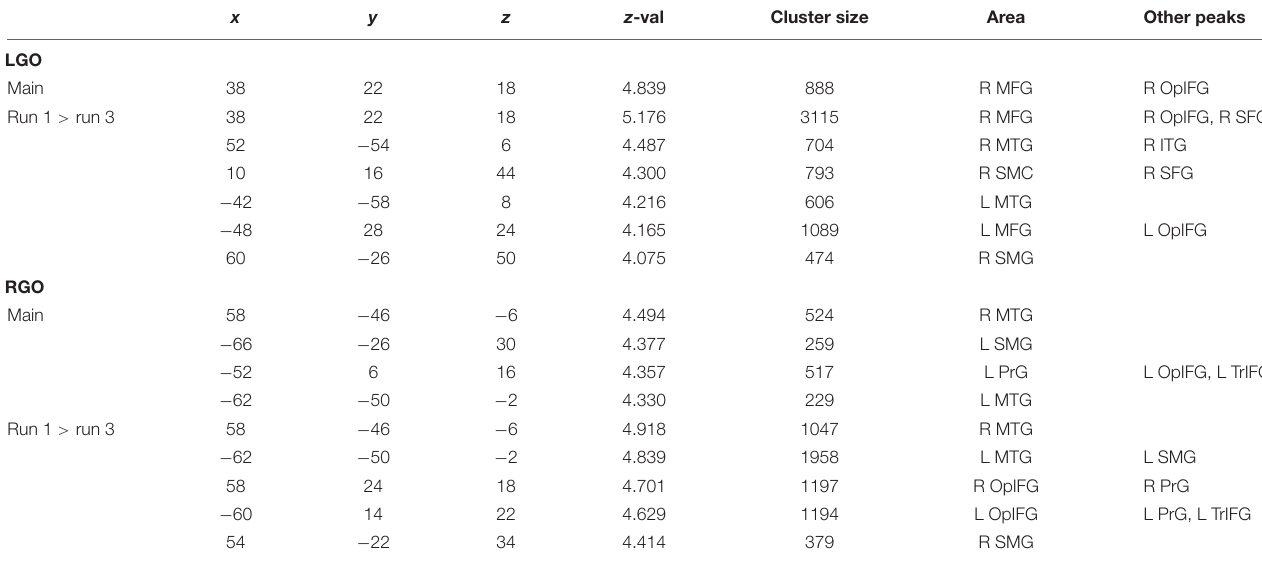
TABLE 5 | Clusters showing significant main effect in a one-way repeated measures analysis of variance for the different tasks across feedback runs. x y z z -val Cluster size Area Other peaks LGO